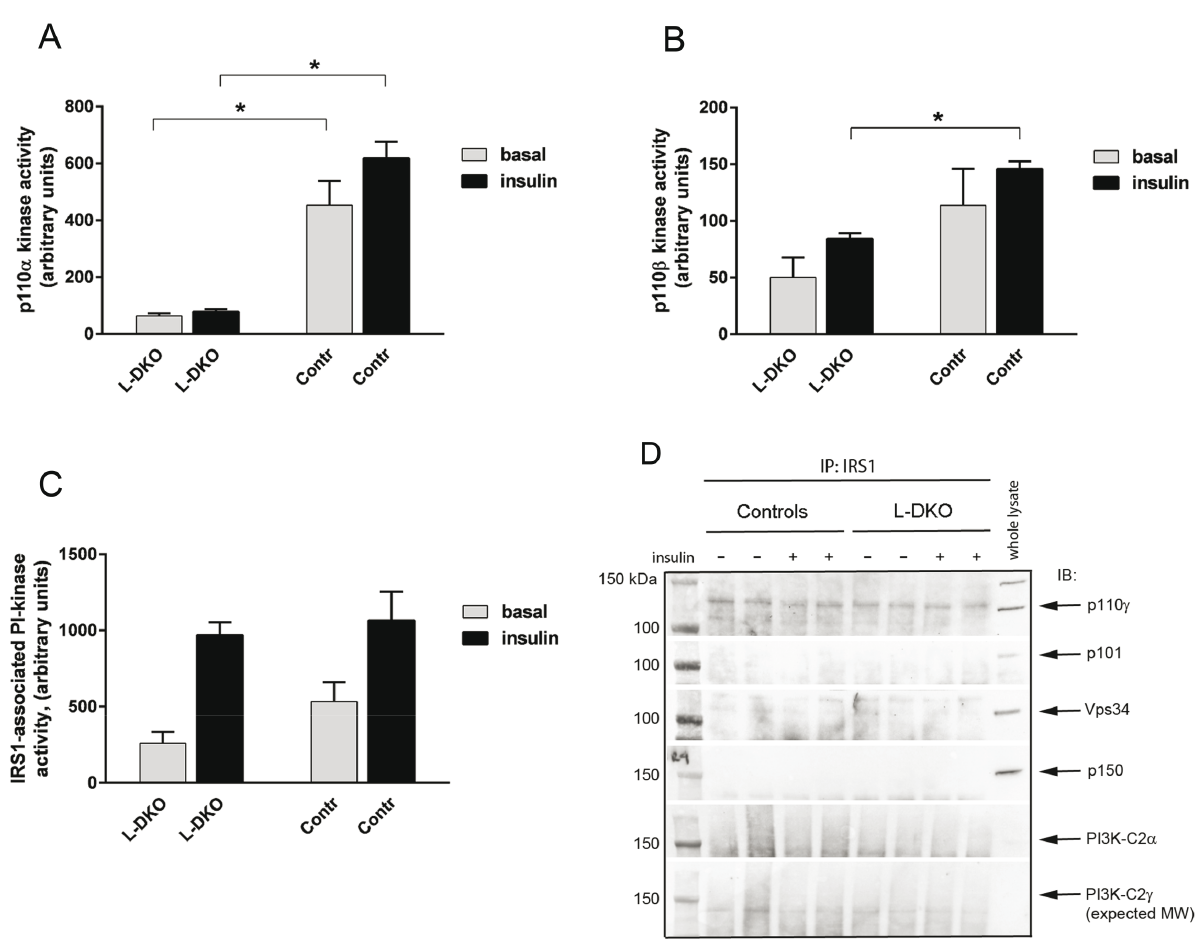
Figure 2. PI3K activity and assessment of the association of IRS1 with class IB-, class II- and class III-members of phosphoinositide 3-kinases. ( A ) p110 α lipid kinase activity, ( B ) p110 β lipid kinase activity, and ( C ) IRS1-associated phosphatidylinositol (PI) kinase activity in L-DKO mice and controls were assessed by immunoprecipitation. ( D ) Representative western blot of immunoprecipitation experiments with antibodies for IRS1 and subsequent immunoblotting with antibodies for p110 γ , p101, Vps34, p150, PIK3-C2 α and PIK3-C2 γ . The whole-lysate reference sample was from an insulin-treated flox control mouse. IP = immunoprecipitation, IB = immunoblot. Basal condition is indicated with a minus (-) sign, insulin-treated condition is indicated with a plus (+) sign. Basal conditions refer to fasting of mice overnight and injection of saline through the vena cava. Insulin treatment refers to injection of 5 U of insulin through the vena cava 5 min prior to euthanization. Error bars indicate SEM (n = 4). *, p < 0.05 compared to controls.